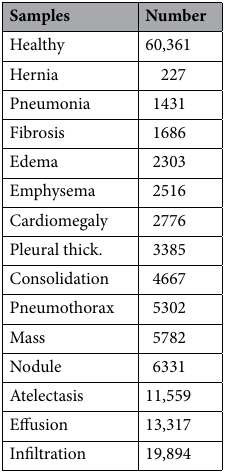
Table 3. The imbalance number of samples.